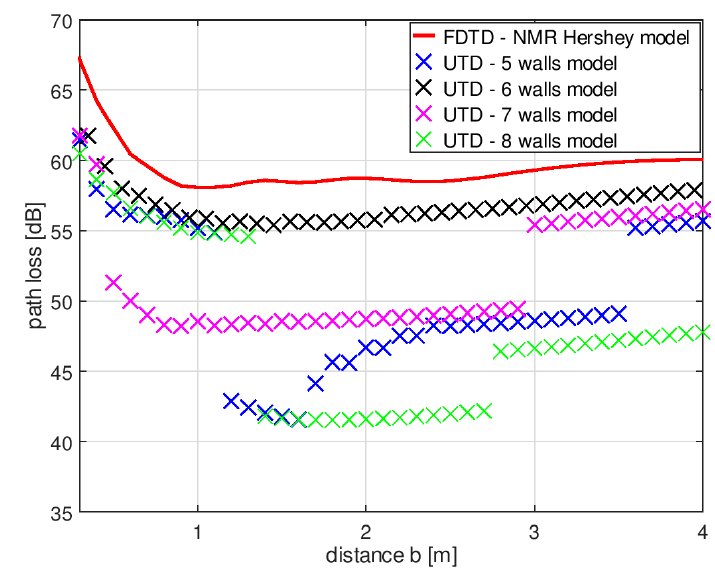
Figure 6. Path loss simulated in the XGtd™ program for different numbers of prism sidewalls compared to path loss simulated in FDTD based program.